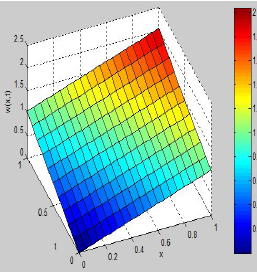
Fig. 13: Surface graph of w ( x , t ) of eq. (8.7), when α = 1